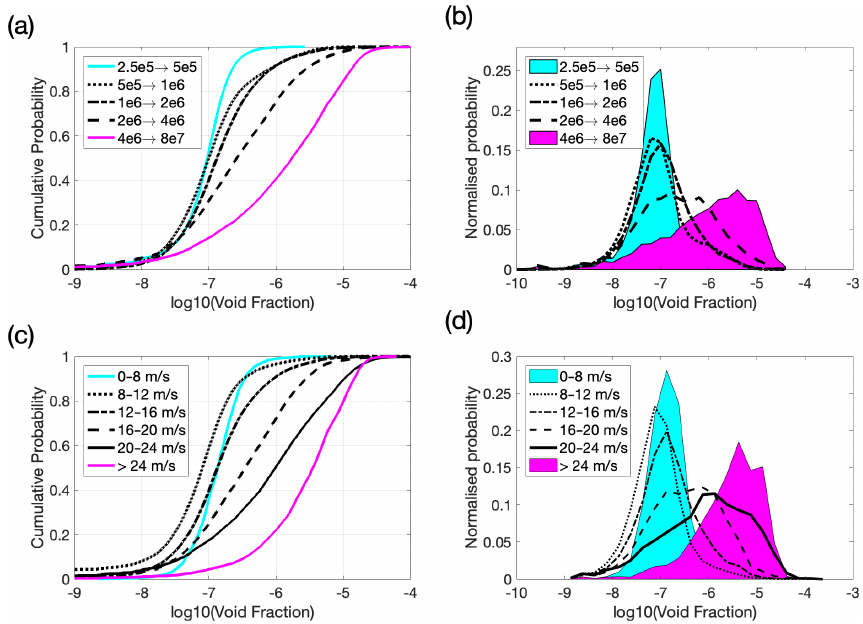
Figure 7. The 1s averaged void fraction probability distributions at 2m depth, split by wind speed (c, d) and wind-wave Reynolds num- ber (a, b) . All the data collected by the bubble camera during all deployments are included in these plots. Panels (a) and (c) show cumulative distributions, and (b) and (d) show the same data as normalised distributions. For (b) and (d) , the shaded regions show the lowest and highest values of the range. Wind speed and Reynolds number are calculated for 10min periods, using the 10min mean for U 10 and the interpolated wind-sea-only significant wave height. We note that although there are data for wind speeds of 0–8ms − 1 , these are all calm periods just after much higher